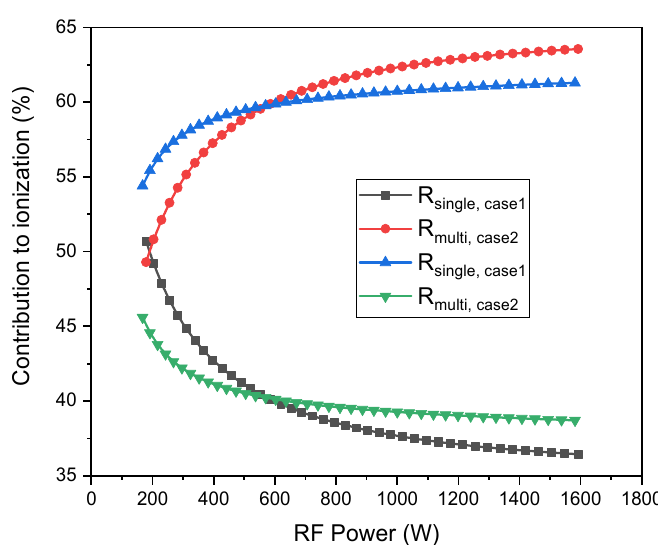
Figure 6. Comparison between contributions to ionization for cases with (case 1) and without (case 2) the complete set of reactions as a function of RF power. Pressure = 2 mTorr.